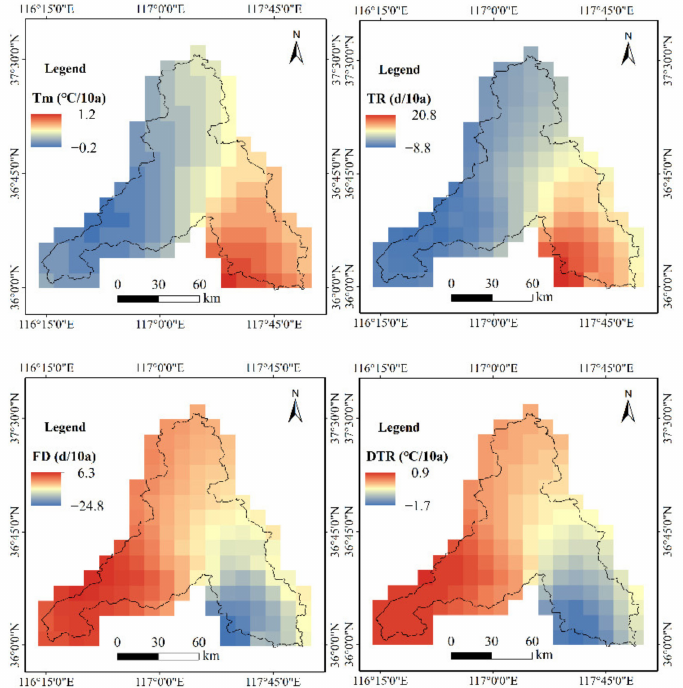
Figure 5. Spatial variation trend of the temperature indices in Jinan City during the period of